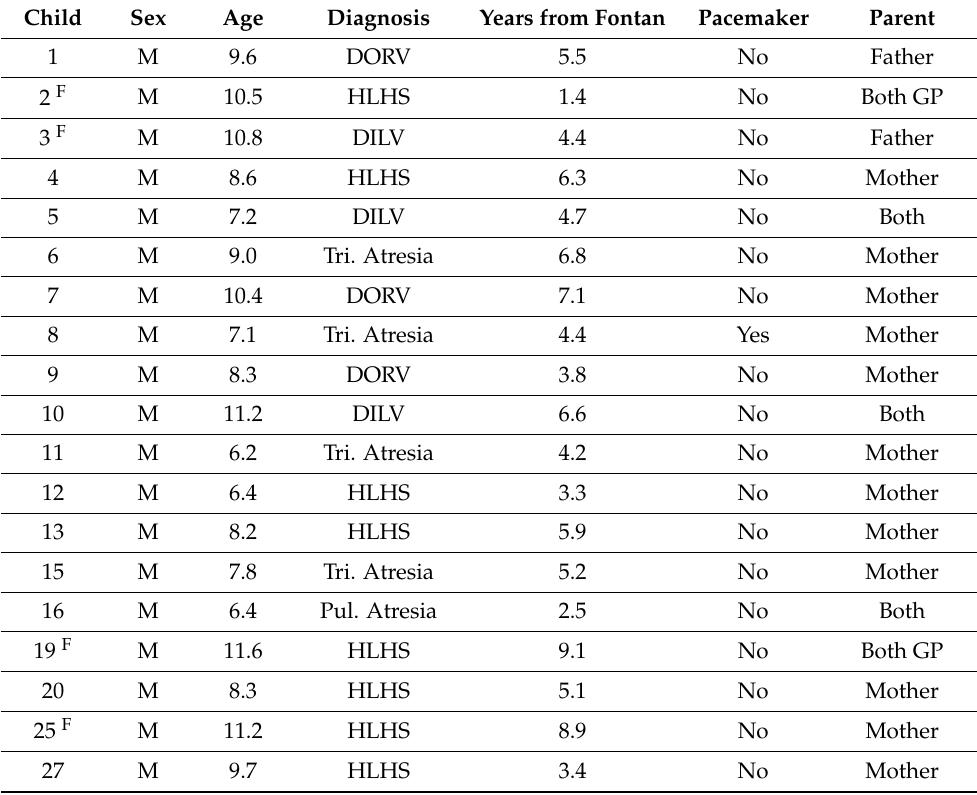
Table 2. Demographic Description of Interview